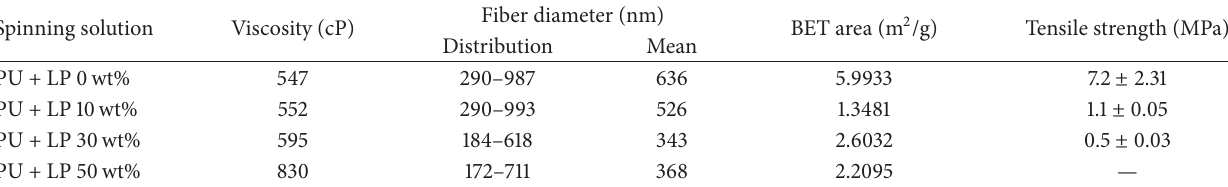
Table 1: Physical properties of PU/LP spinning